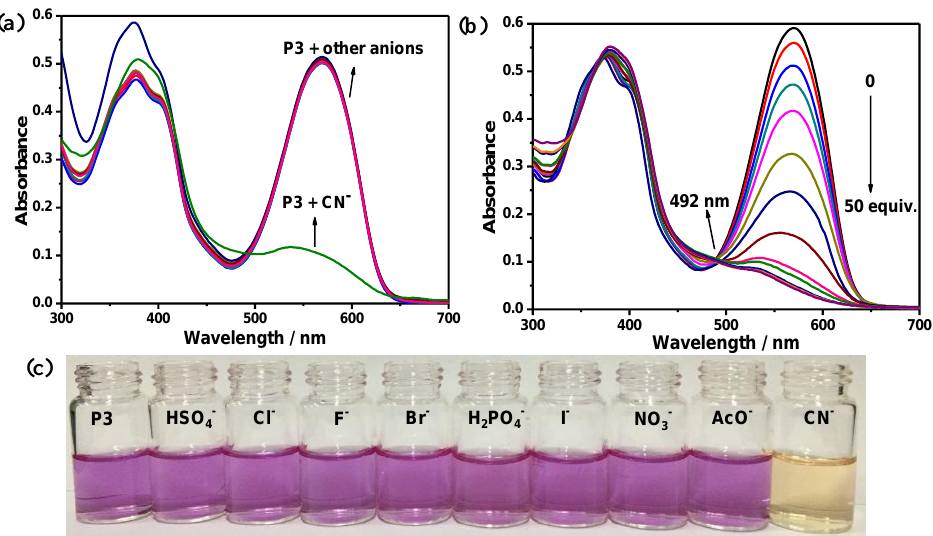
Figure 6. ( a ) UV-Vis spectra of P3 ([RU] = 30 μM) in THF/H 2 O (98:2, v/v ) in the presence of 20 equiv. of different anions; ( b ) UV-Vis spectral changes of P3 ([RU] = 30 µM) in THF/H 2 O (98:2, v/v ) upon addition of an increasing concentration of CN − (0, 120, 240, 270, 300, 330, 360, 390, 420, 450, 480, 510, 540, 570, 600, 700, 800, 900, 1000, 1200 and 1500 µM); and ( c ) visual images observed for P3 solutions upon addition of 50 equiv. each anion.